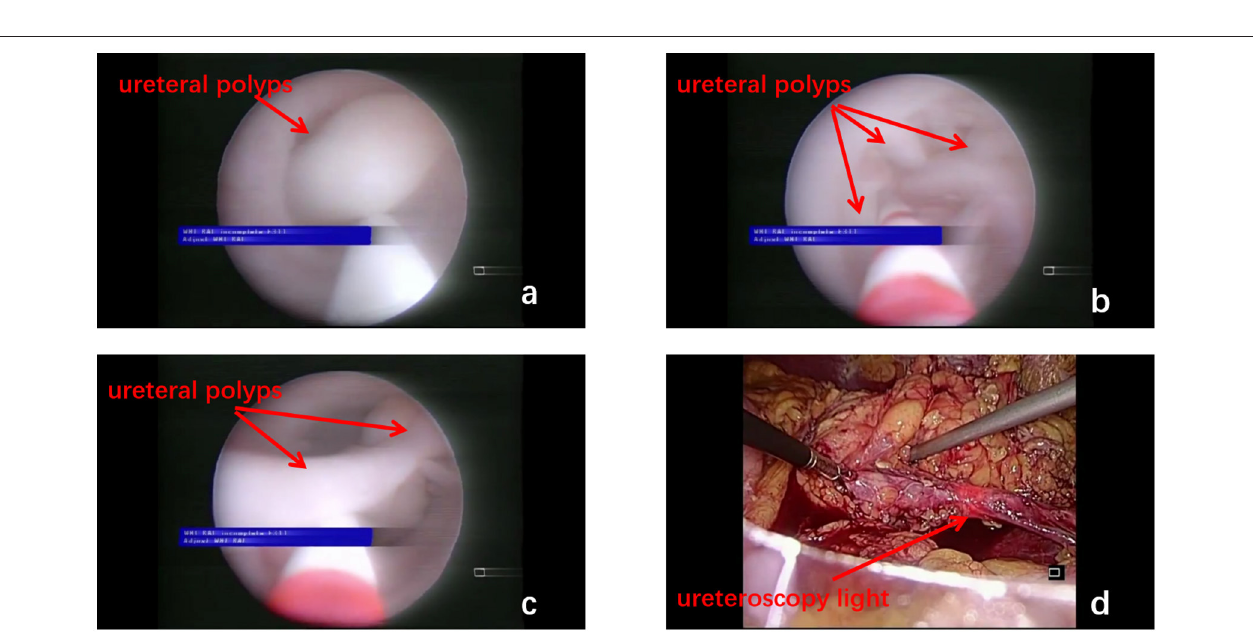
trocar was inserted into the lateral margin of the rectus, 3– 4 cm above the umbilicus ( Figure 1 , point B). A third trocar was placed at the midpoint between the navel and the anterior superior iliac spine as the working ports ( Figure 1 , point